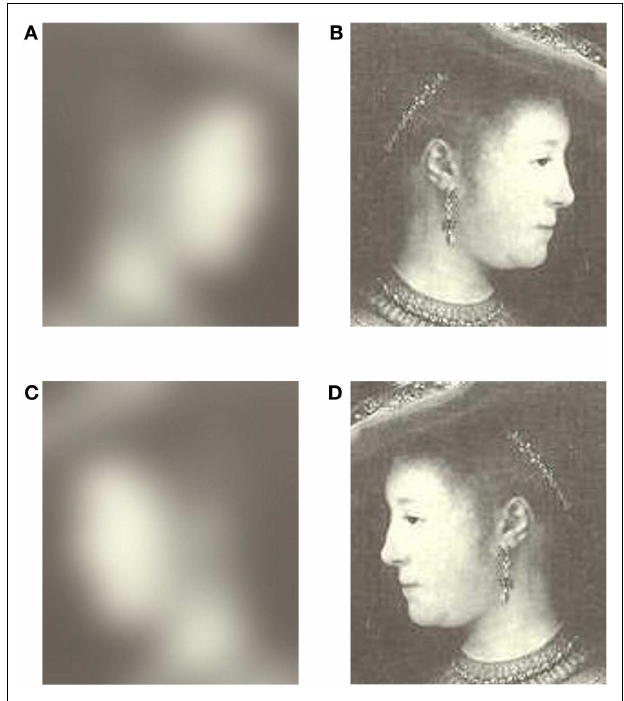
FIGURE 2 | (A) Blurred original orientation, (B) original orientation of a left-cheeked female, (C) blurred mirror-reverse, and (D) mirror-reverse orientation (A woman in fanciful costume). Baltimore,TheWalters Art Gallery; Br. 386). Copyright 1969 Phaidon Press Ltd. Rembrandt, The Complete Edition of Paintings . A. Bredius, revised by H.